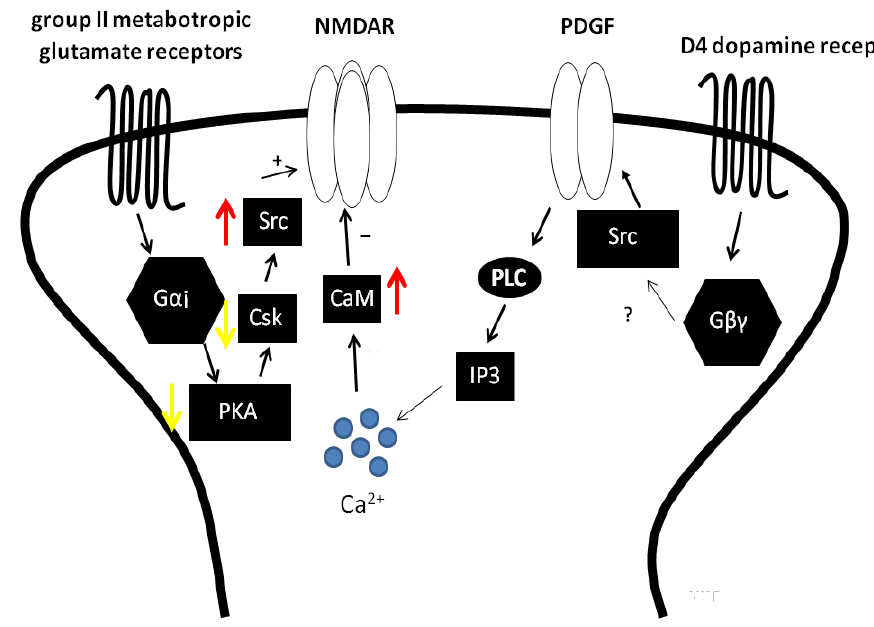
Figure 3. Gαi coupled receptors increase or decrease NMDAR function depending on the signalling pathways recruited. The activation of dopamine D4 receptor depresses NMDAR mediated currents by transactivating PDGF receptors. The resulting increased PLC activity hydrolyzes PIP leading to the generation of IP and DAG. The release of Ca 2+ from 2 3 internal stores following IP receptor stimulation activates CaM, which then promotes 3 calcium dependent inactivation of NMDARs. In contrast, activation of group II mGluRs enhance NMDAR mediated currents via PKA/Csk/Src dependent